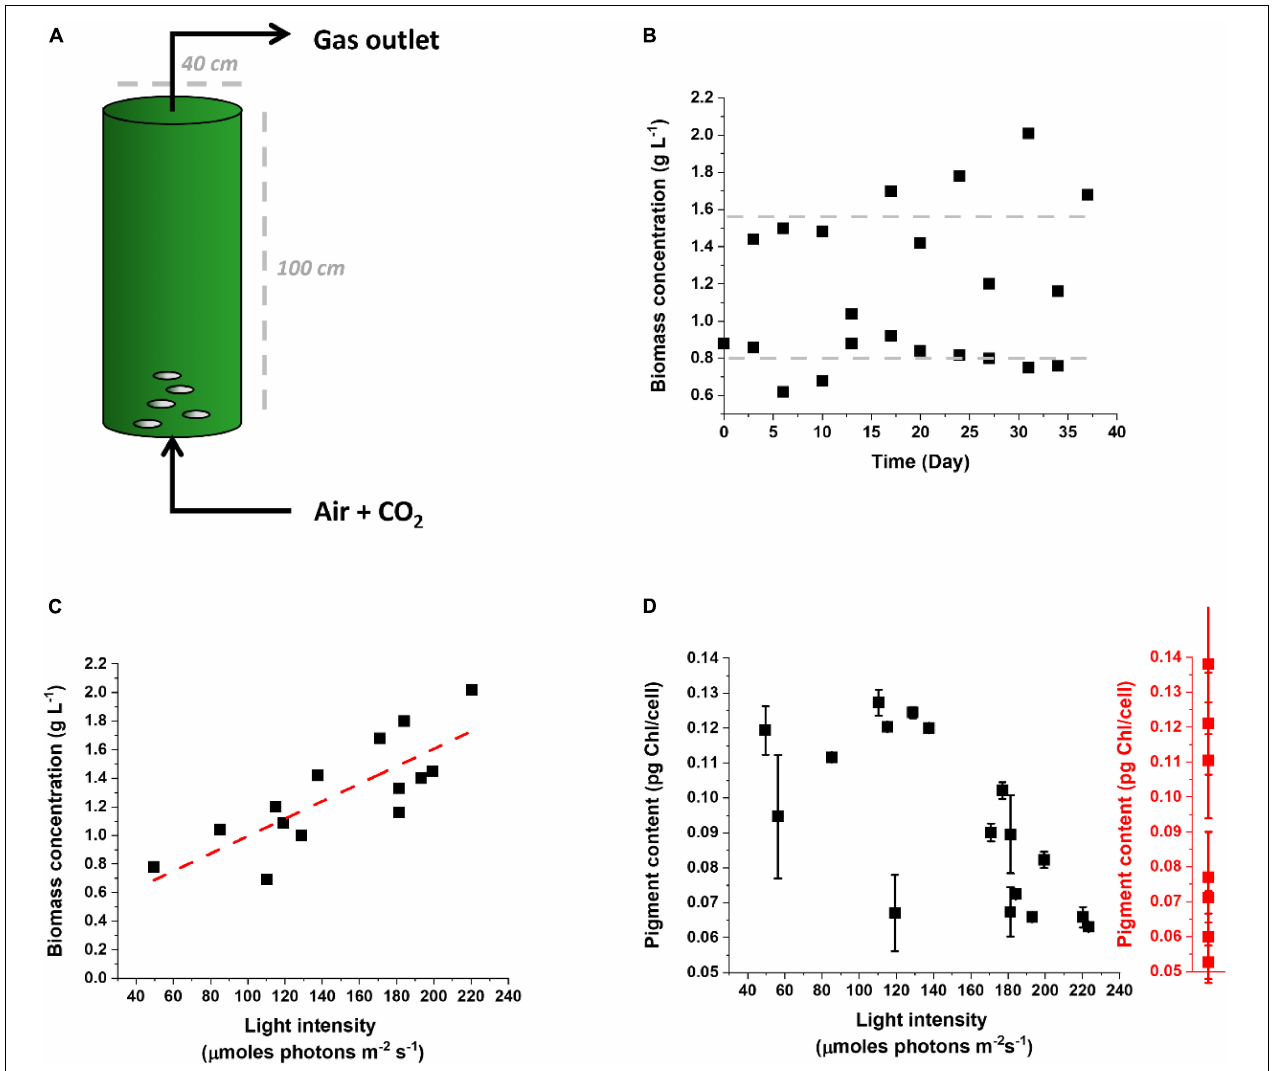
FIGURE 6 | Cultivation of Nannochloropsis gaditana in a pilot PBR outdoor. (A) Scheme of the pilot PBR used to cultivate Nannochloropsis outdoor. Nutrients and CO 2 were provided in excess to highlight the effect of the natural light supply rate on productivity. (B) The culture was operated in a semicontinuous mode for more than 1 month, restoring a biomass concentration of 0.8 g L − 1 every other day. (C) Correlation between biomass concentration and light intensity reaching the culture. Light intensity was calculated as the average of illumination over 24 h. The linear trend is highlighted by a red dashed line. (D) Correlation between the pigment content of Nannochloropsis cells cultivated outdoor in the pilot PBR of panel (A) and the light intensity reaching the culture. The range of values of Chl content observed for the same cells cultivated in the lab and exposed to different irradiances is indicated by the red plot on the right. Data for the latter were collected for the lab conditions summarized in Supplementary Table 1